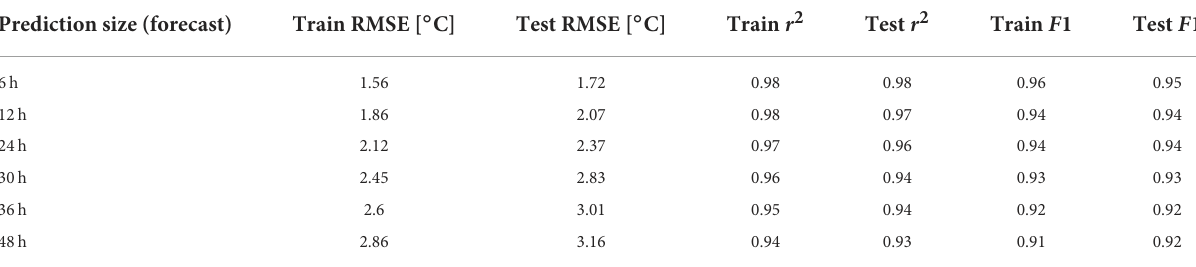
TABLE 2 Statistics for the results of the RF model prediction at various lead-times. Random forest model statistics